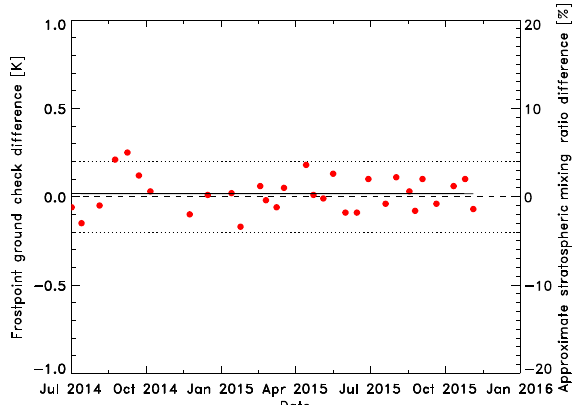
Figure 12. Difference of CFH dew point measurements prior to launch and a reference measurement inside the inlet tube. Dots in- dicate the individual measurements; the solid line indicates a linear fit through all